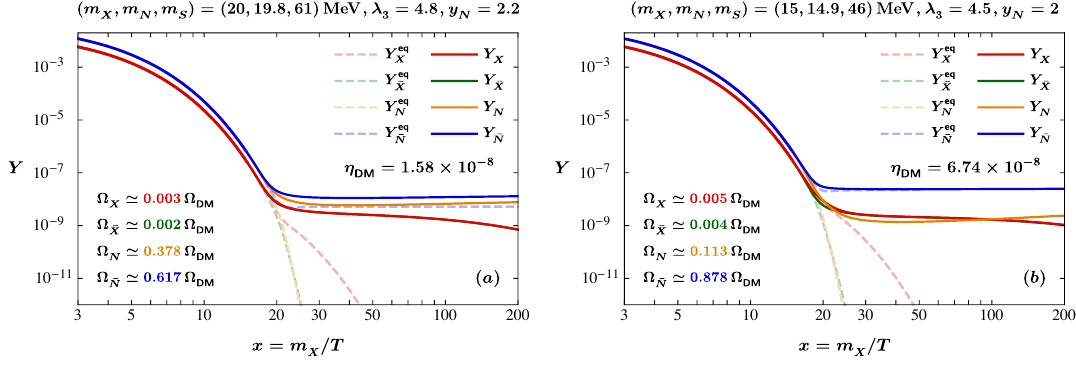
Figure 6 . Time evolution of the comoving number yields of DM for r where we have chosen the same inputs of (cid:15), m